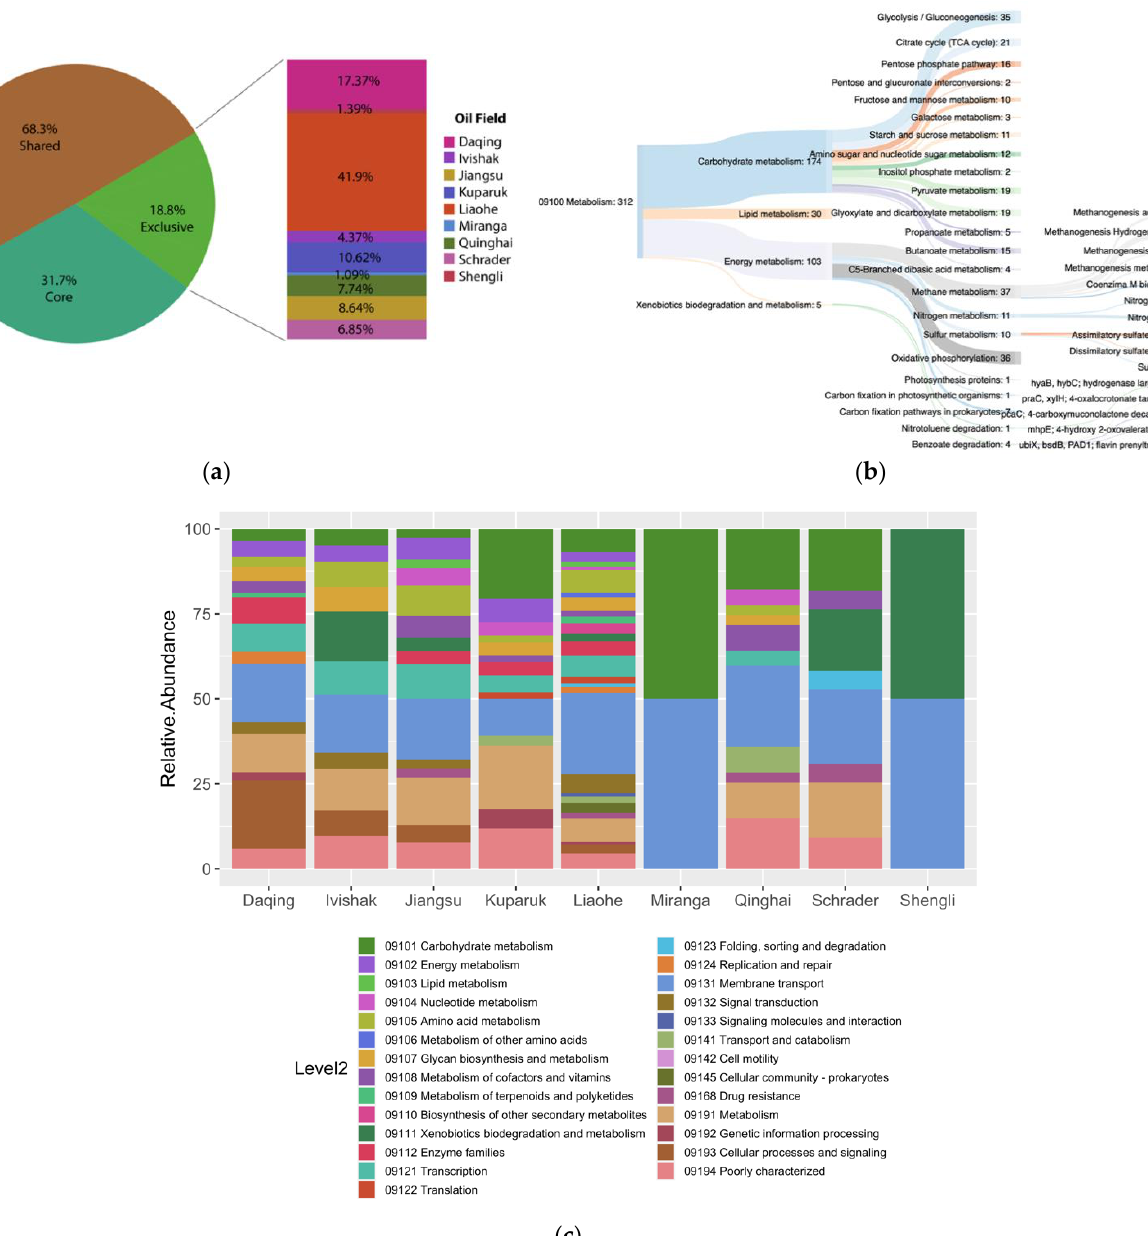
Figure 7. ( a ) Pie chart with percentages of specific KEGG orthologies from each oil field. ( b ) Main core metabolisms. ( c ) Exclusive orthologies at level 2 KEGG categories.